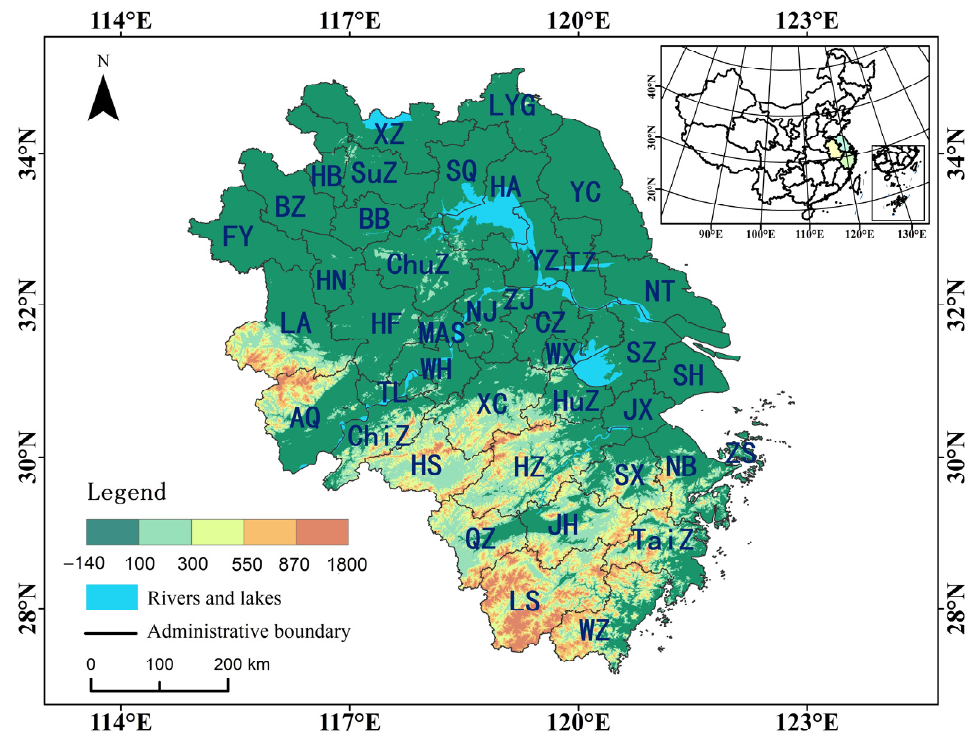
Figure 1. Administrative scope and geographical location of the Yangtze River Delta.